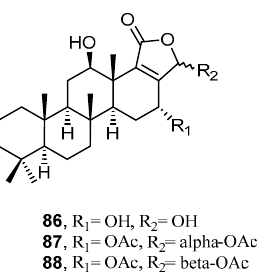
Figure 22. Chemical structures of the sesterterpenes 90 – 102 .